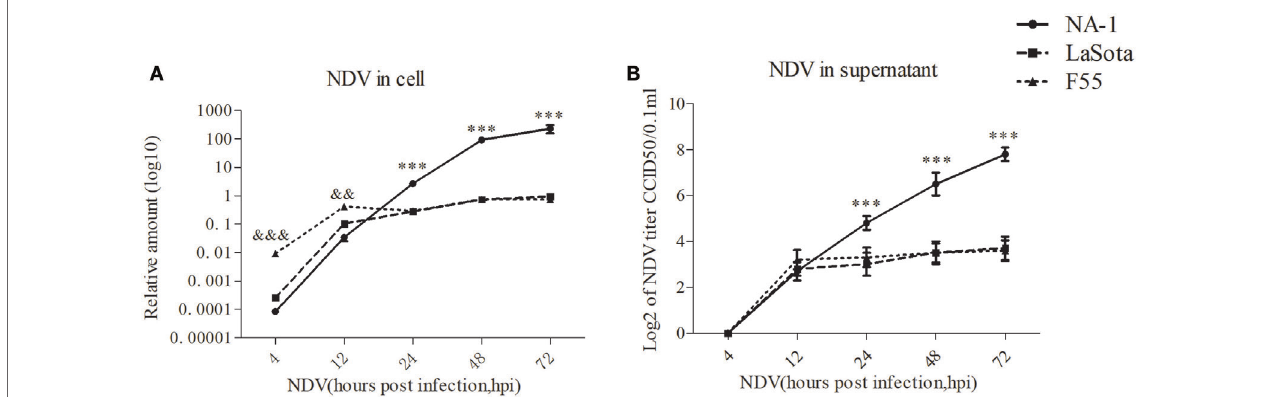
FigUre 2 | Virulent Newcastle disease virus (NDV) replicates rapidly than lentogenic viruses in chicken macrophages. The relative viral genome load in HD11 cells infected with three different virulence and genotypes NDV strains (including virulent class II genotype VII strain NA-1, lentogenic class II strain genotype III strain LaSota, and lentogenic class I genotype I strain F55) at a MOI of 2 for 4–72 h post infection (hpi) was measured by qPCR (a) . The virus titer in the supernatants was quantified by the micro-HA method (b) . The relative virus genome amount was normalized to the geometric mean of cellular endogenous genes β -actin and hydroxymethylbilane synthase and qPCR data were calculated using the 2 −Δ Ct method. Furthermore, viral RNA genome in cells and infectious virus titer in supernatants were undetected in all uninfected cells. All values are shown as mean ± SEM ( n = 4–6) and differences were considered significant if * P < 0.05, ** P < 0.01, and *** P < 0.001 as compared to the two lentogenic virus LaSota and F55 strains infected cells, &&& P < 0.001 as compared to the virulent virus NA-1 strain infected cells. All data are representative of at least three independent